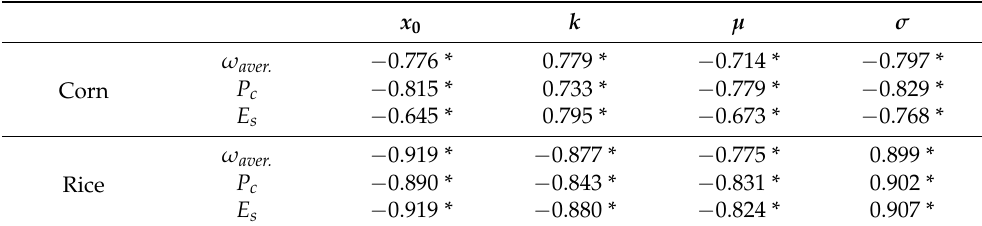
Table 5. The results of the Spearman correlation analysis between the average angular velocity of the working unit, power consumption and specific comminution energy and the parameters of RRSB distributions. x 0 k µ σ ω aver. − 0.776 * 0.779 * − 0.714 * − 0.797 * P c − 0.815 * 0.733 * − 0.779 * − 0.829 * Corn